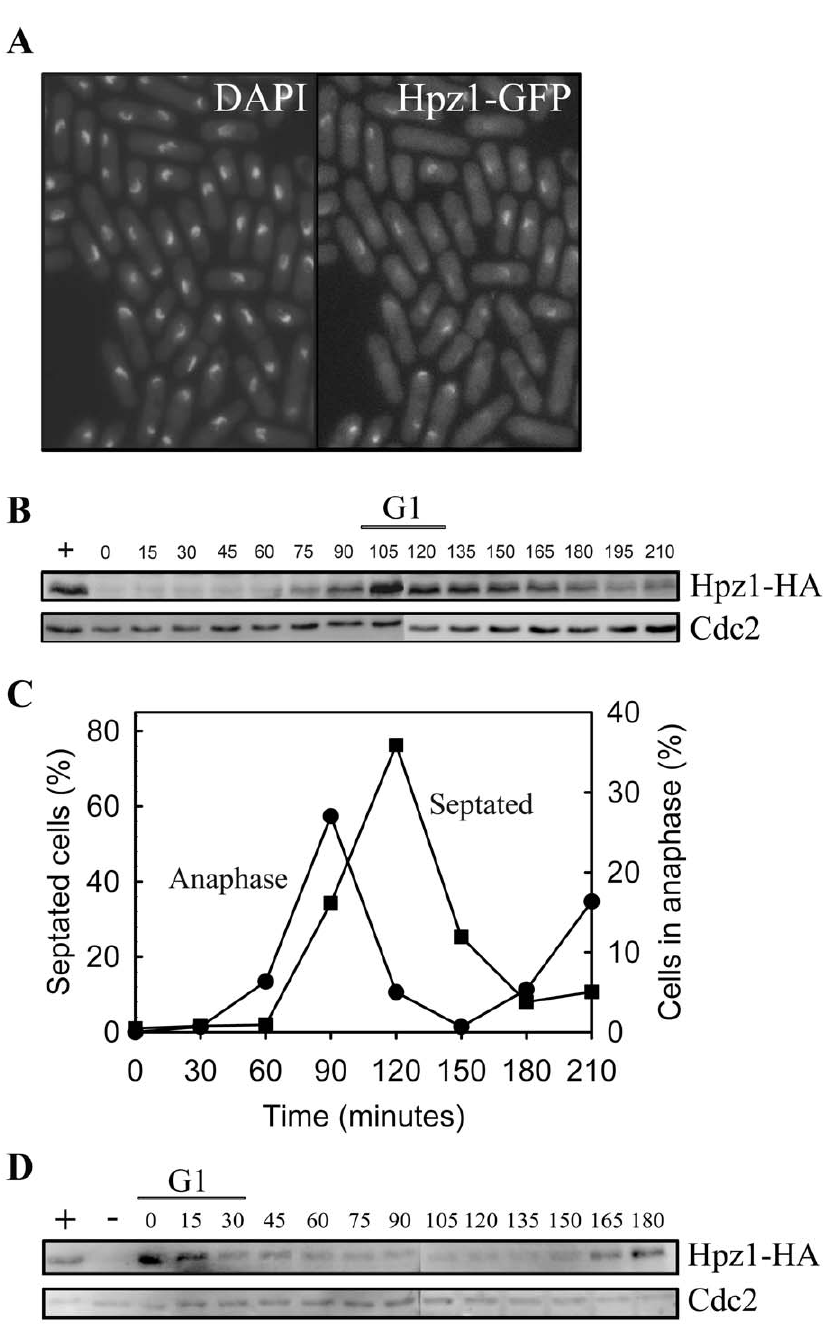
Figure 4. Cell-cycle regulation and localization of Hpz1. Fluorescence microscopy pictures showing all nuclei (DAPI-staining, left) and Hpz1- GFP localization (right) in the same cells. B. Immunoblot showing the expression of Hpz1-HA in total cell extracts taken at the indicated time points after a cdc25 block-and-release. C. The percentage of cells in anaphase (DAPI-stained cells with 2 nuclei) or septated cells (stained with aniline blue) from the experiment shown in panel B. D. Immunoblot showing the presence of Hpz1-HA in total cell extracts taken at the indicated time points after a cdc10 block-and-release.